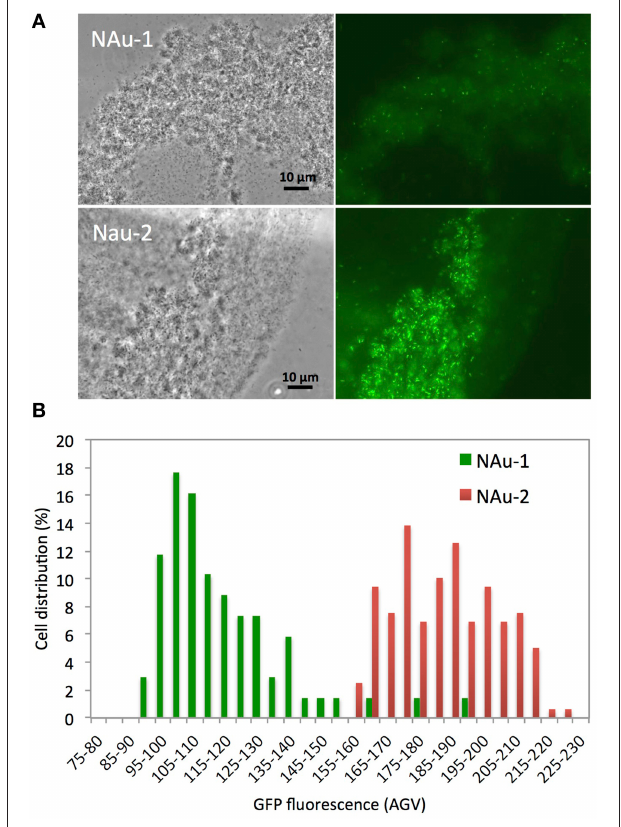
FIGURE 6 | Fluorescence of siderophore deficient P. aeruginosa strain PAO1 1 pvdD 1 pchEF containing an iron regulated bfrB - gfp gene fusion incubated in direct contact with nontronite particles. (A) Representative transmission (left panels) and fluorescence (right panels) micrographs showing aggregation of bacteria with NAu-1 (top panels) and NAu-2 (bottom panels) particles. (B) Expression of GFP in individual cells determined from analysis of images captured by fluorescence